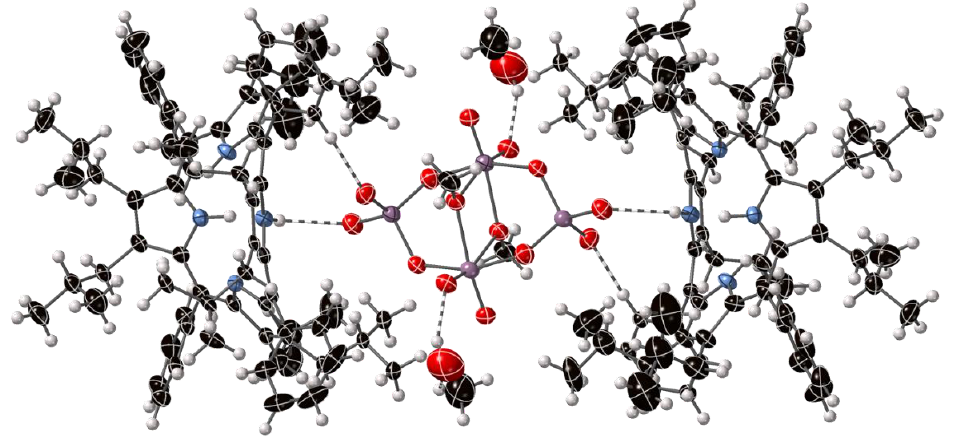
Figure 8. The N–H · · · O and C–H · · · O interactions of the serendipitous precipitation of the [H 3 2 ] + Figure 8. The N – H ⋯ O and C – H ⋯ O interactions of the serendipitous precipitation of the [H 3 2 ] + por- porphyrinium monocation with an in situ-generated [Mo 4 O 12 (OMe) 2 ] 2 − POM unit (compound 9 phyrinium monocation with an in situ-generated [Mo 4 O 12 (OMe) 2 ] 2− POM unit (compound 9 ).